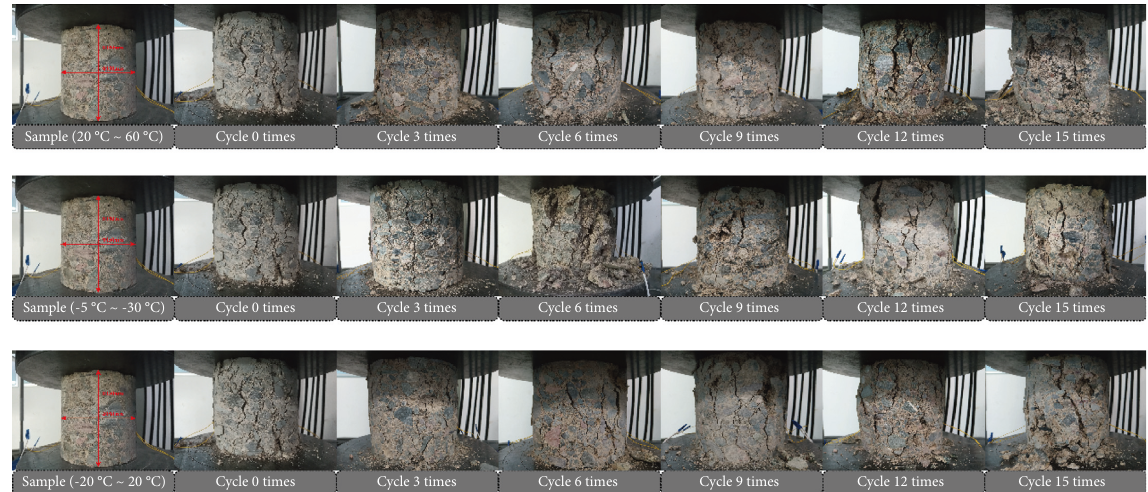
Figure 6: Failure modes at different temperature intervals and number of